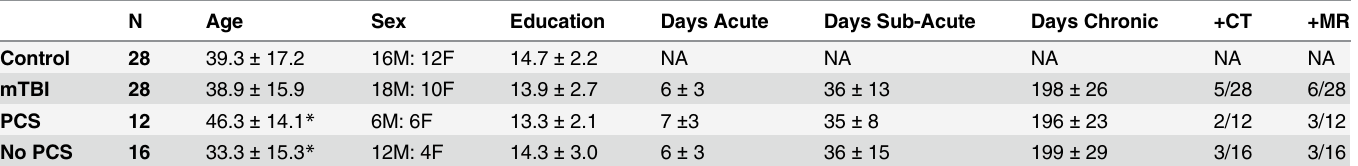
Table 1. Participant